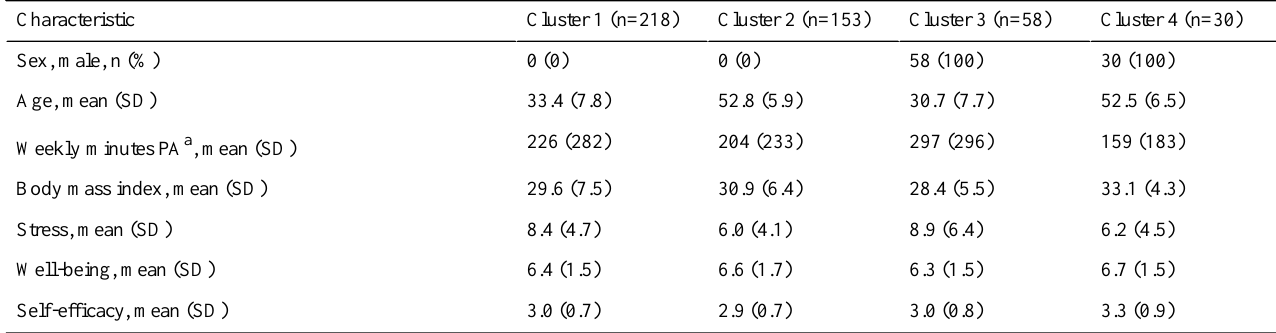
Table 2. Female and male clusters sex, age, physical activity level, body mass index, stress, well-being, and self-efficacy per cluster.